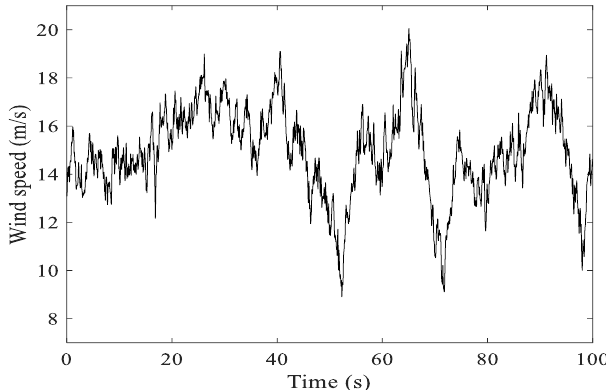
Figure 12. Turbulent wind of 16 m/s.